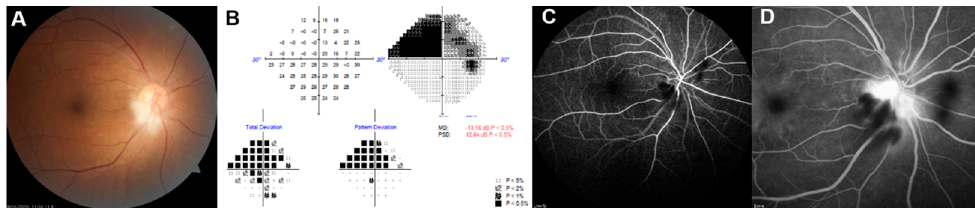
Figure 2. ( A ) Color fundus photo revealed inferior sectoral optic disc swelling and focal cotton wool spots in the peripapillary area of right eye. ( B ) Humphrey visual field test shows a superior altitudinal deficit. ( C ) Fluorescein angiography shows an early filling defect in the inferior segment of the optic nerve, and late leakage from optic disc ( D ).